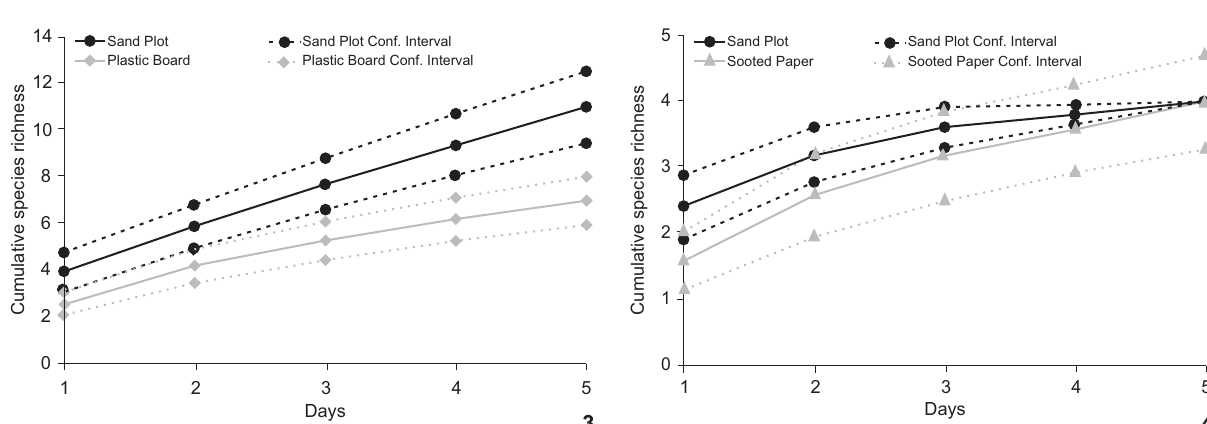
Sand Plot Conf. Interval Plastic Board Plastic Board Conf. Interval